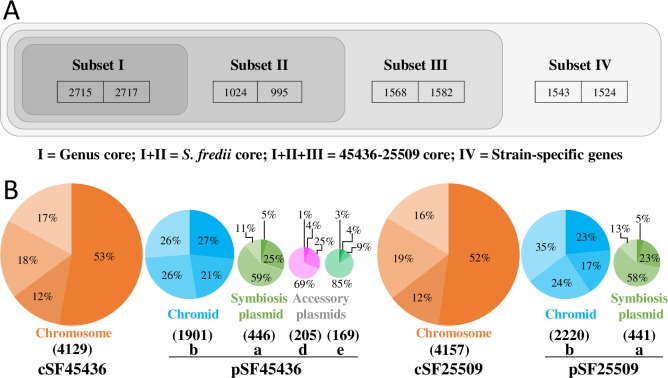
Biased distributions of core and accessory genes regarding replicons.(A) A schematic diagram illustrating the hierarchical division of core/accessory subsets for the genomes of S. fredii CCBAU45436 and CCBAU25509. Subset I, genus core genes present in all strains; subset II, genes present in all S. fredii strains excluding subset I; subset III, genes shared by CCBUA45436 and CCBAU25509 but not present in all S. fredii strains, i.e. excluding subsets I and II; subset IV, the remaining accessory genes in either CCBAU45436 or CCBAU25509. The actual total gene numbers of each subset within the genome of CCBAU45436 (left) and CCBAU25509 (right) are shown in frames. The slight differences between two strains in the numbers of core genes in subsets I-III are due to the counting of multi-copy genes belonging to the same homologous gene cluster, which can include one or more genes in each strain. (B) Percentage values are the ratios of genes included in hierarchical core/accessory subsets (shades of colors from deep to light: I, II, III, IV), harbored by each replicon within the genome of CCBAU45436 or CCBAU25509. The actual total gene numbers of each replicon are shown in parentheses. Pearson's chi-square test of independence indicates the distribution of different core/accessory subsets on replicons is not random (CCBAU45436, X-squared = 1455.3, df = 12, P < 2.2E-16; CCBAU25509, X-squared = 1010.4, df = 6, P < 2.2E-16).